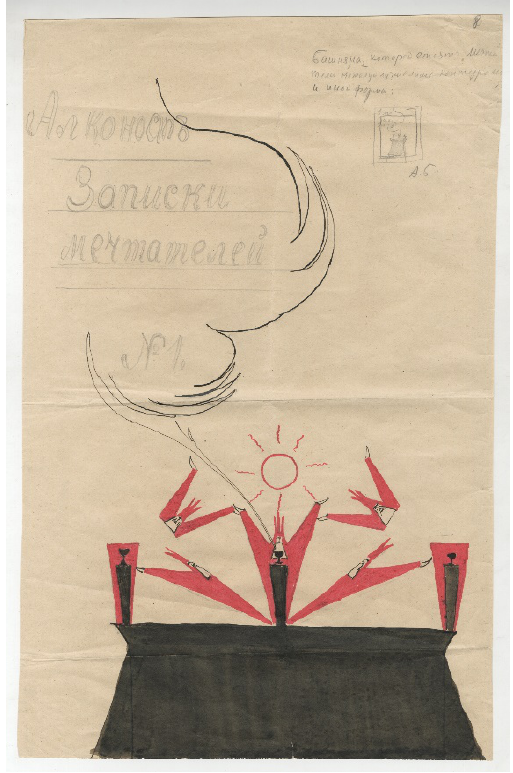
Figure 8. Bely’s sketch for the journal cover Dreamers’ Notes. 1918–1919. RGALI.